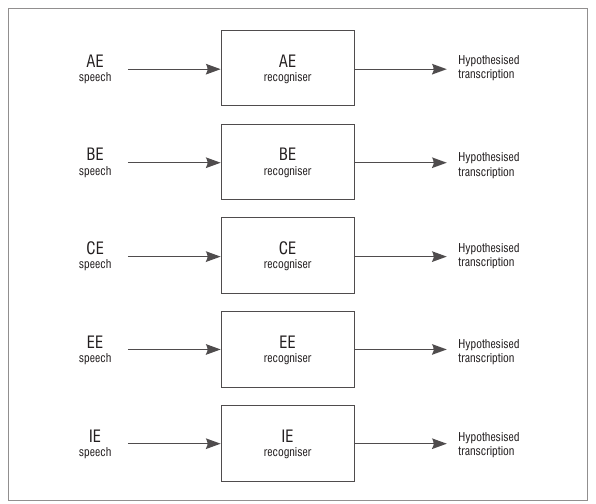
Figure 3: Oracle configuration in which each test utterance is presented only to the accent-specific recognition system with matching accent for speech recognition in the five South African English accents: White South African English (EE), Indian South African English (IE), Black South African English (BE), Afrikaans English (AE) and Cape Flats English (CE).